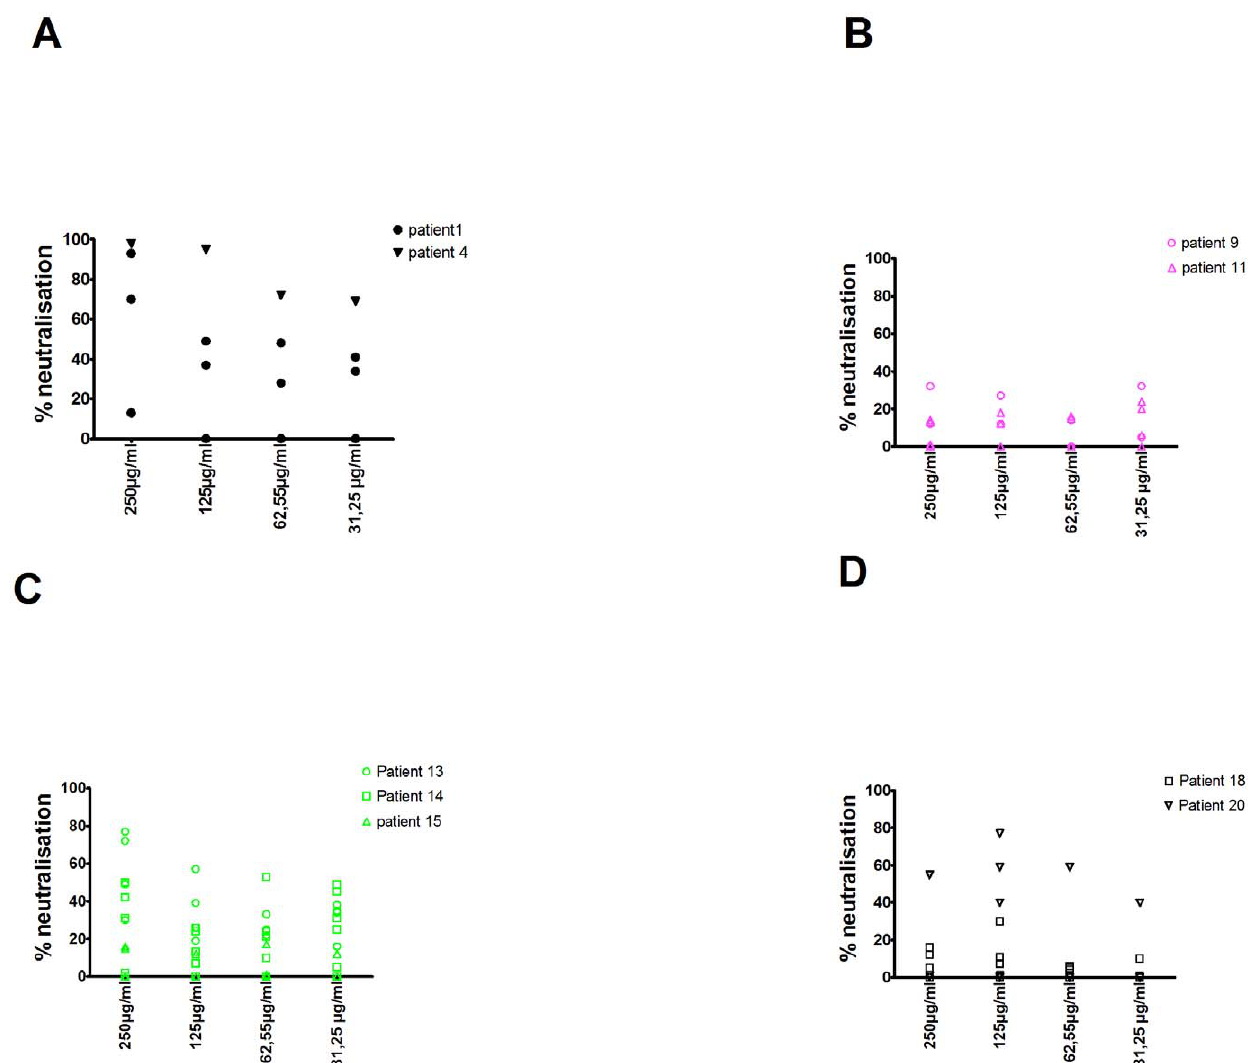
Figure 6. Autologous neutralizing antibodies. IgG was purified and Env was cloned from the same plasma sample in each patient. The neutralizing capacity of IgG was tested in the TZMbl assay, using single cycle chimeric pseudoviruses, containing the respective autologous Env. This assay could be performed for 2 SC (A), 2 SNC (B), 3 TN (C) and 2 HAART patients (D). Percent neutralization in Y-axis is shown over a concentration range of individual patient IgG, given in X-axis. Each patient is represented by one symbol and in many patients several autologous Env clones were tested.